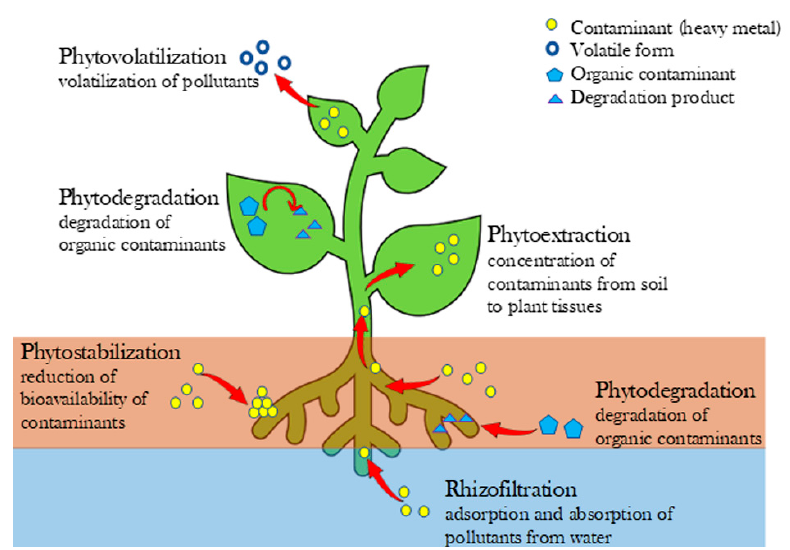
Figure 1. Schematic representation of different phytoremediation approaches by plants under study.